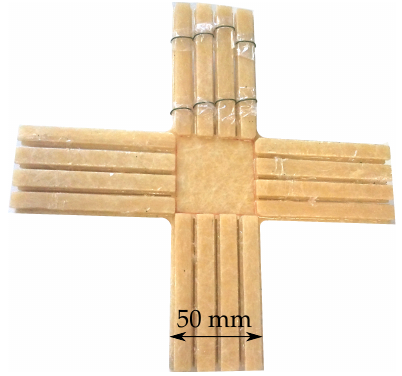
Figure 7. Image of the cruciform specimen with bonded reinforcements on the arms, thickness of the area of interest: 2